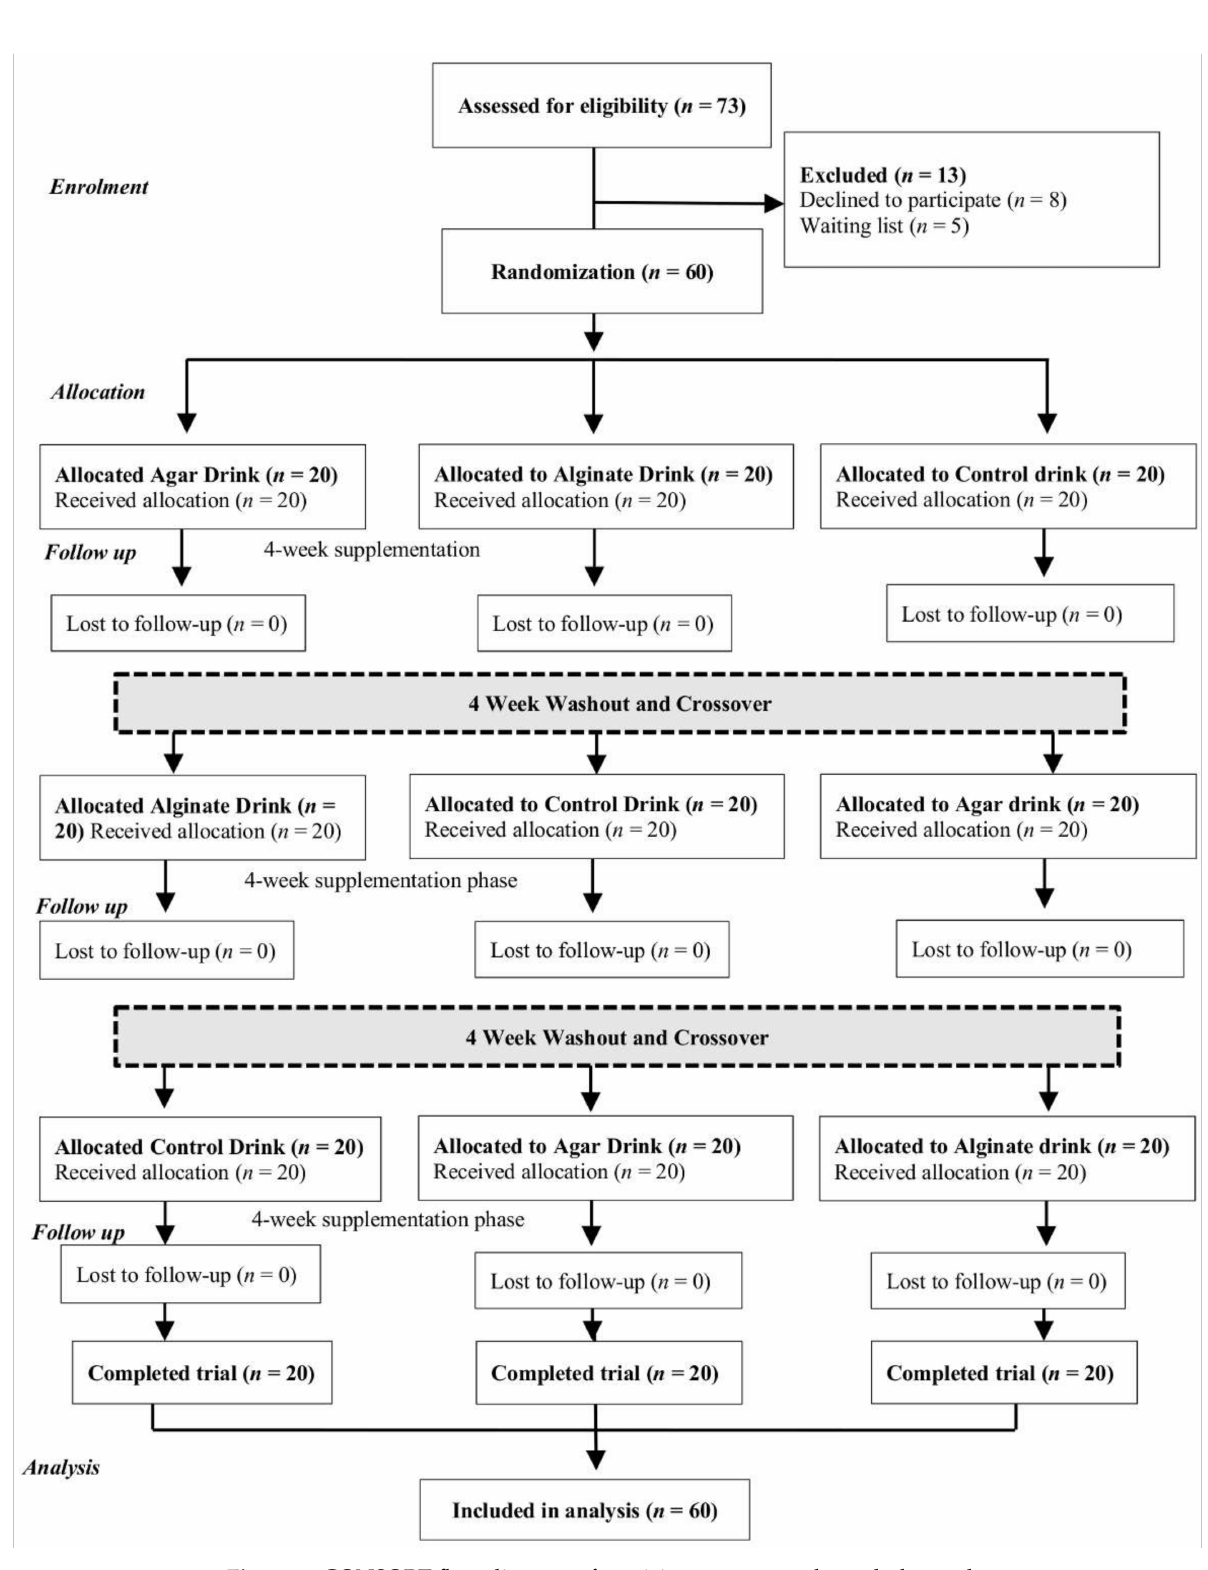
Figure 1. CONSORT flow diagram of participant progress through the study.